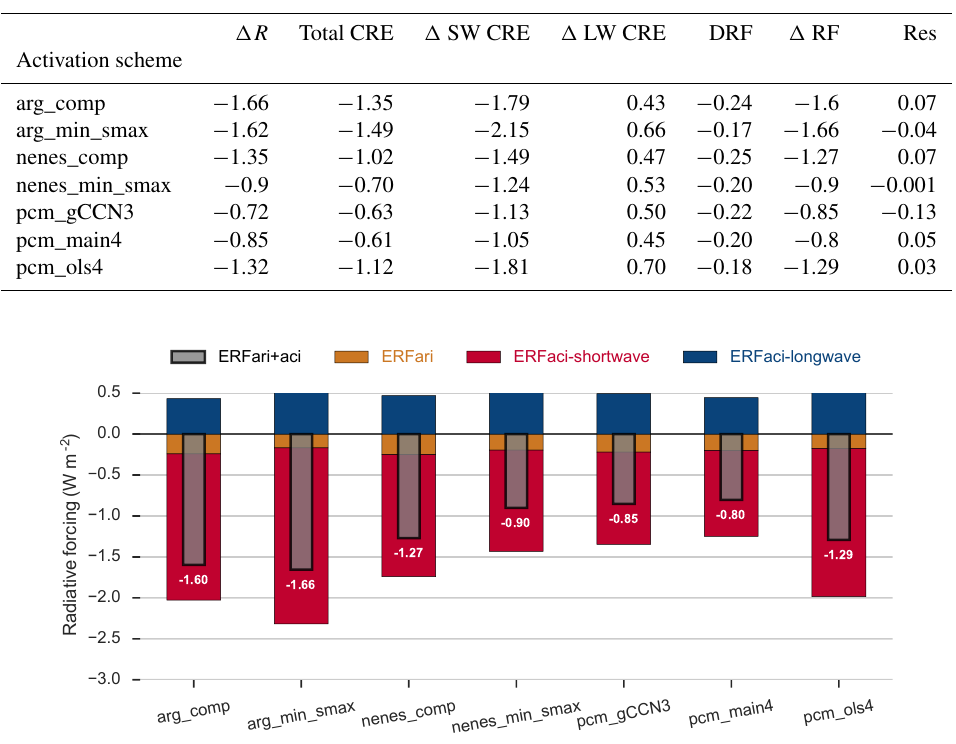
Table 2. Aerosol direct and indirect effects (in Wm 2 ) for the different activation schemes considered in this study. In all cases, we consider the change in the top-of-atmosphere radiative flux to compute these metrics (the net balance of which is given by (cid:49)R ). Our decomposition of the shortwave cloud radiative effect (SW CRE) follows Ghan (2013) to account for above-cloud scattering and absorbing aerosol; similarly, the direct effect is computed diagnostically within each simulation. Following Gettelman (2015) we compute a residual (Res) between the top-of-atmosphere radiative imbalance and the direct and indirect effects such that Res = total CRE + DRF − (cid:49)R .